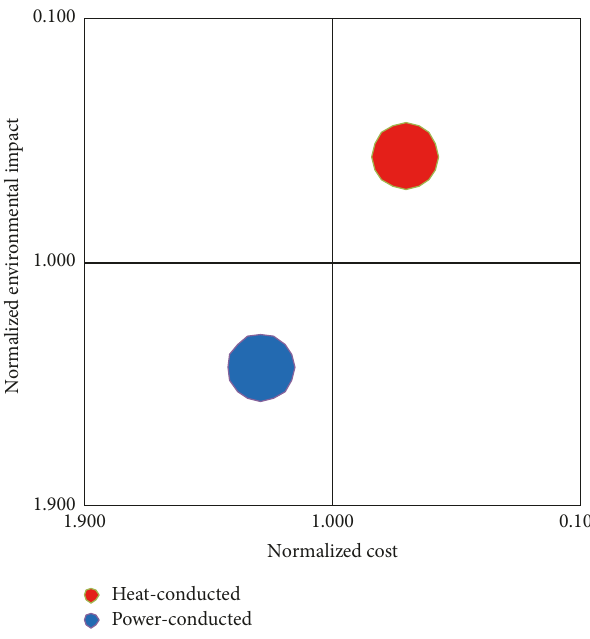
Figure 10: Results from the eco-efficiency analysis; see text.